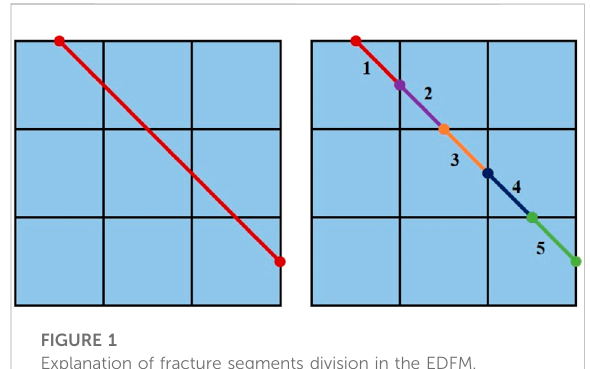
FIGURE 1 Explanation of fracture segments division in the